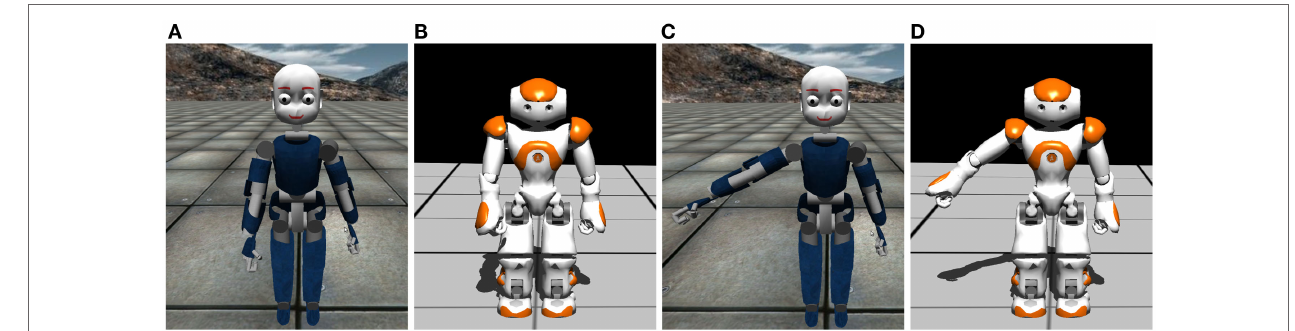
FIGURE 6 | The generic robotic reflexes produced and executed by the same Reflex module through TCI . Two stimulations are simulated on the NAO and iCub robots, respectively. Images (A,B) illustrate the reflexes from the stimulations located on the bottom of the forearms, while stimulations illustrated in images (C,D) are inside of the